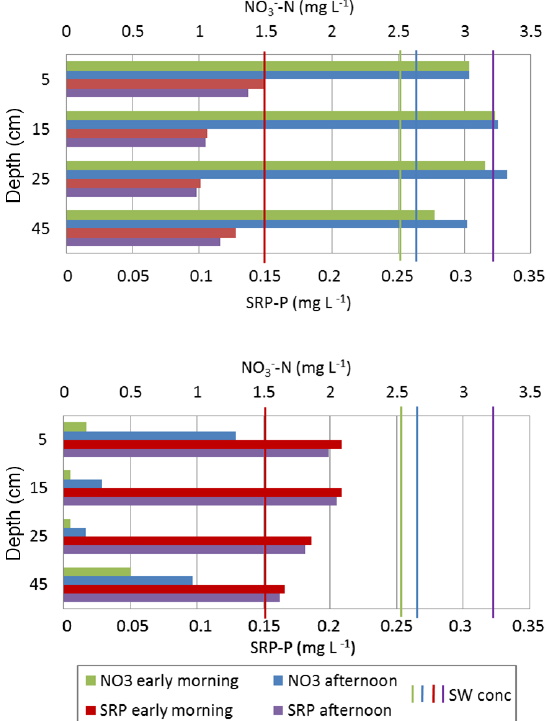
Figure 6. Concentrations of NO − -N and SRP in time differentiat- 3 ing manually taken pore-water samples from MLS A (bottom) and MLS B (top) on 8 October 2015. Corresponding surface water con- centrations are marked as vertical Figure 5. Comparison between manually sampled pore water from MLS (red) and HPFM (blue) for NO − -N (top) and SRP (bottom). 3 Each MLS was sampled on 4 and 11 June 2015. Average surface water concentration during the deployment time and the concentra- tions at the time point of MLS sampling are marked in green.